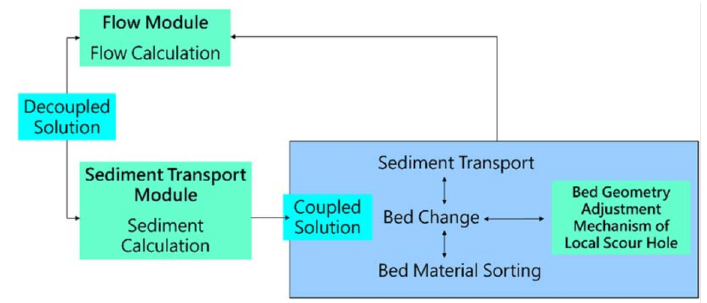
Figure 3. Flowchart of the computational modules used in this